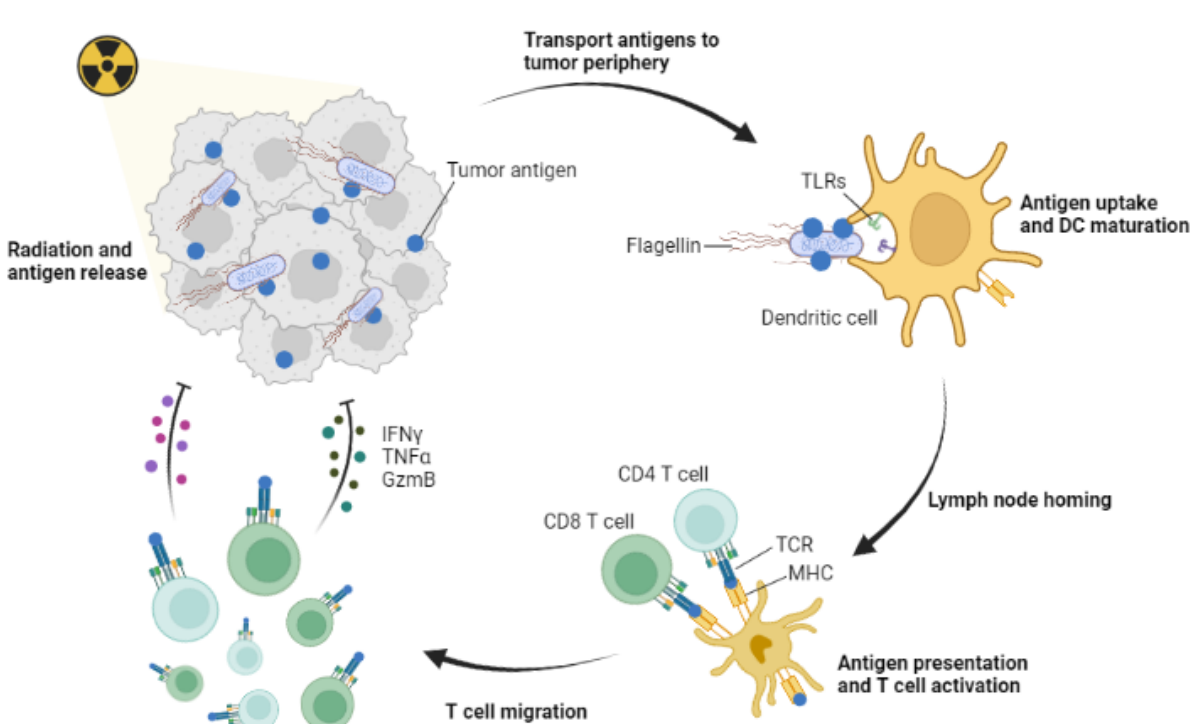
FIGURE 1: Systemic immune responses via the transport antigens to tumor periphery by Antigen-capture bacteria. The tumor antigen is released by radiotherapy. AC-Bacteria captures the released tumor antigen through electrostatic interaction, and then transports the tumor antigen to the tumor periphery through its own motion characteristics. The antigen is taken up by the functional DCs. The DCs then homed to the lymph nodes to present antigens and activate CD4+ and CD8+ T cells. T cells migrate to the tumor site through the vasculature and attack the tumor by secreting cytokines, etc. IFNγ, interferon-γ; TNFα, tumor necrosis factor α; GzmB, granzyme B; MHC, major histocom- patibility factors; TCR, T cell receptor; TLRs, toll-like